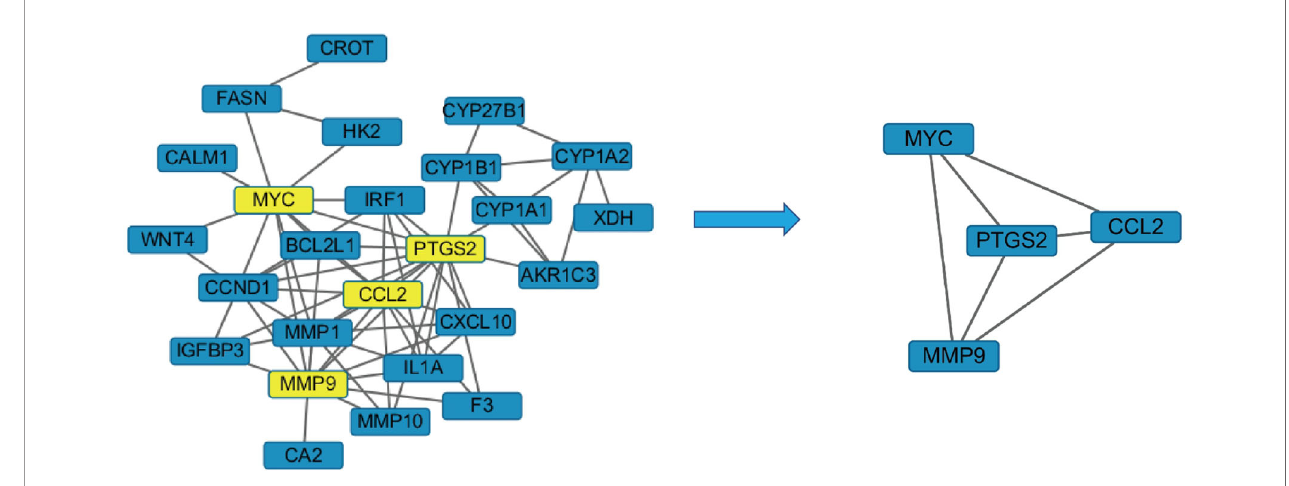
FIGURE 6 | The disease target-PPI network.